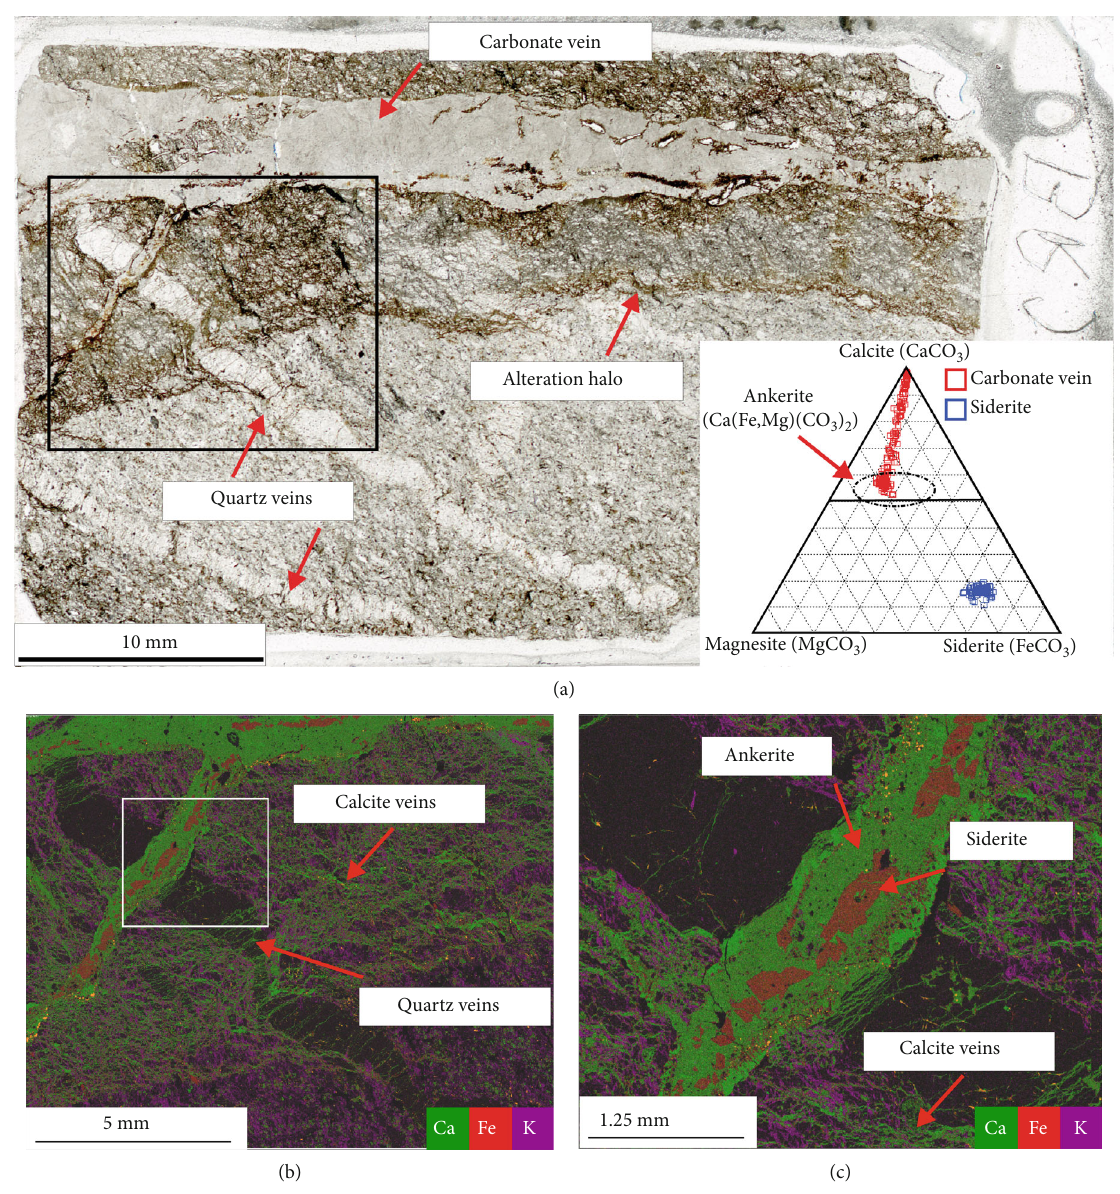
Figure 5: Geochemistry and mineralogy of hydrothermal carbonate veins. (a) Scan of a thin section of a hydrothermal carbonate vein from the altered greyschist showing a distinct alteration zone with cross-cutting segmented quartz veins. Ternary diagram of magnesite-calcite- siderite, showing the compositions of the carbonate veins. The carbonate vein shows a compositional variation between calcite and ankerite. (b) Element map (Ca, Fe, and K) of the carbonate vein and alteration zone (location in (a)) showing a network of thin calcite veins de fi ning the alteration zone. (c) Close-up element map of the white box in (b), showing a carbonate vein containing ankerite, siderite, and